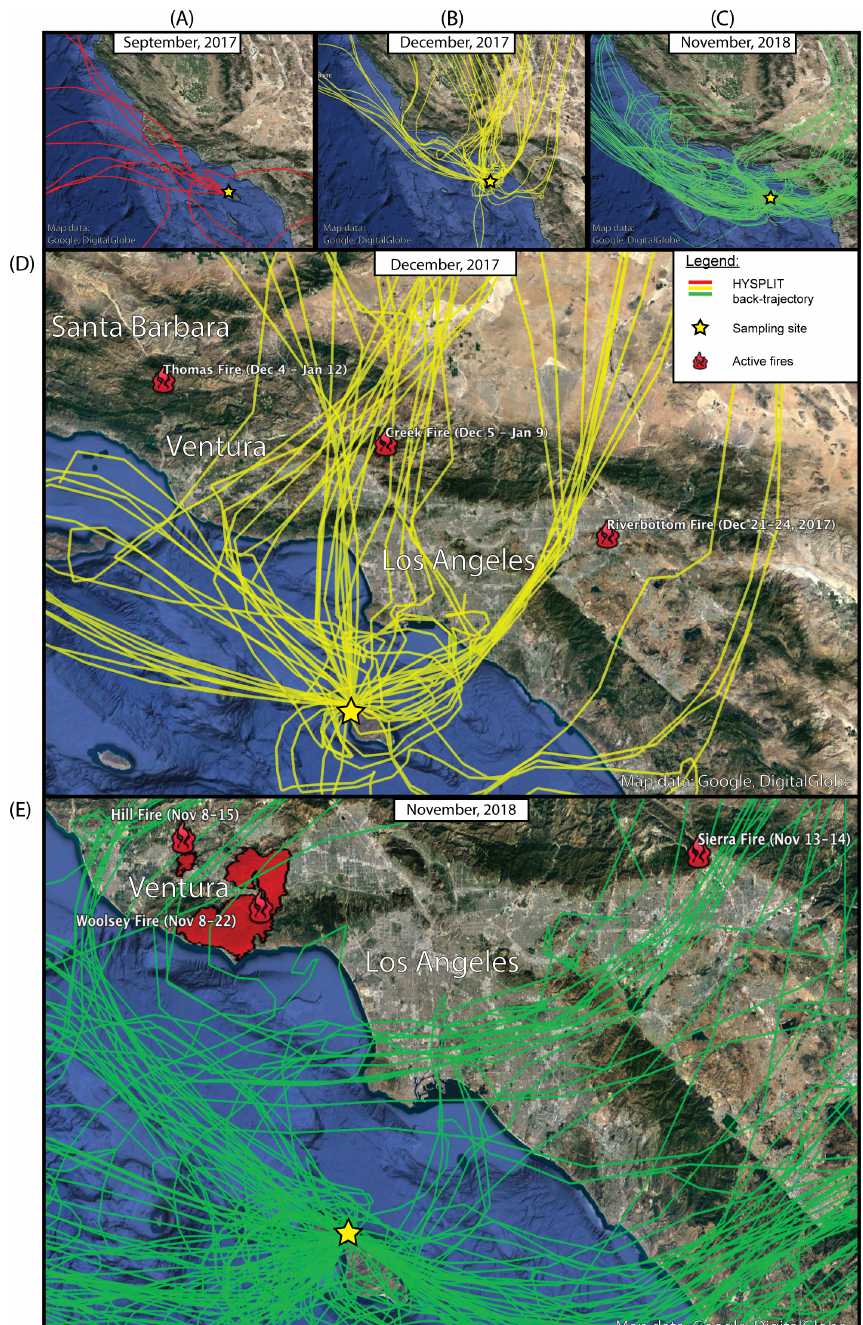
Figure 3. HYSPLIT back-trajectories for all three campaigns. The star denotes the starting location of each back-trajectory, i.e., the sampling location. The trajectories for the first period (September 2017; a ) represent week-long back-trajectories for each day of the campaign. The trajectories for the second (December 2017; b ) and third (November 2018; c ) periods represent 72h back-trajectories for each hour of the campaign. Panels (d) and (e) show more zoomed-in maps of the respective second and third campaign back-trajectories along with active southern California fires. Map data © Google